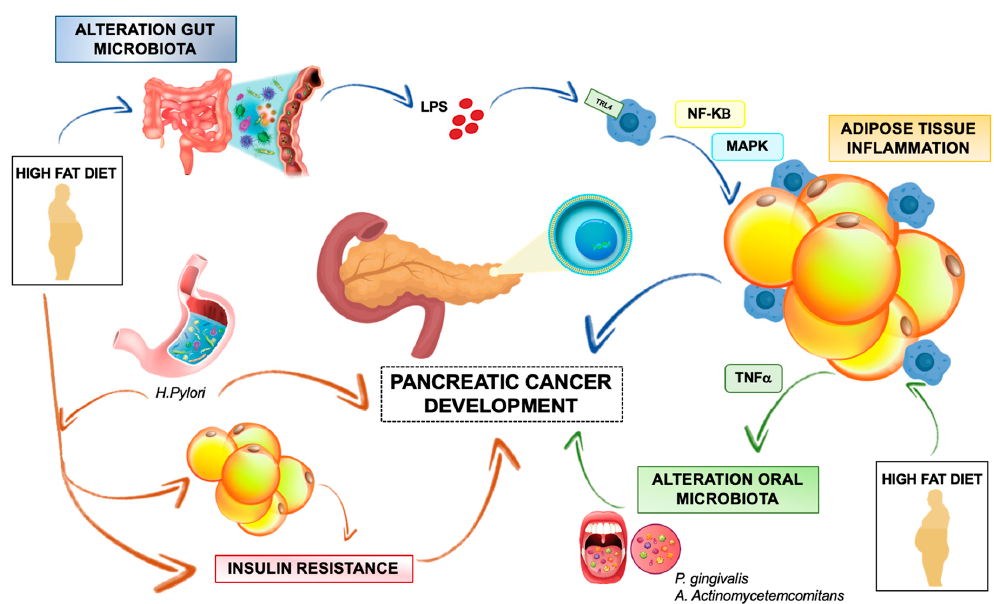
Figure 2. Overview of interactions between gut microbiota, adipose tissue and pancreatic cancer development. High fat diet (HFD)-induced gut dysbiosis promotes systemic lipopolysaccharide (LPS) release and subsequent activation of TRL4 receptor in adipose tissue macrophages. Resulting adipose tissue inflammation contributes to PC development (blue lines). HFD-promoted adipose tissue inflammation favors periodontal inflammation and oral colonization by pathogen bacteria that are related with increased risk of PC (green lines). Gastric colonization by Helicobacter pylori fosters HFD-mediated central obesity and insulin resistance, both of which promote PC growth. PC may also be favored by direct translocation of Helicobacter pylori -derived protein antigen toward pancreatic tissue and subsequent pancreatic inflammation (orange lines).